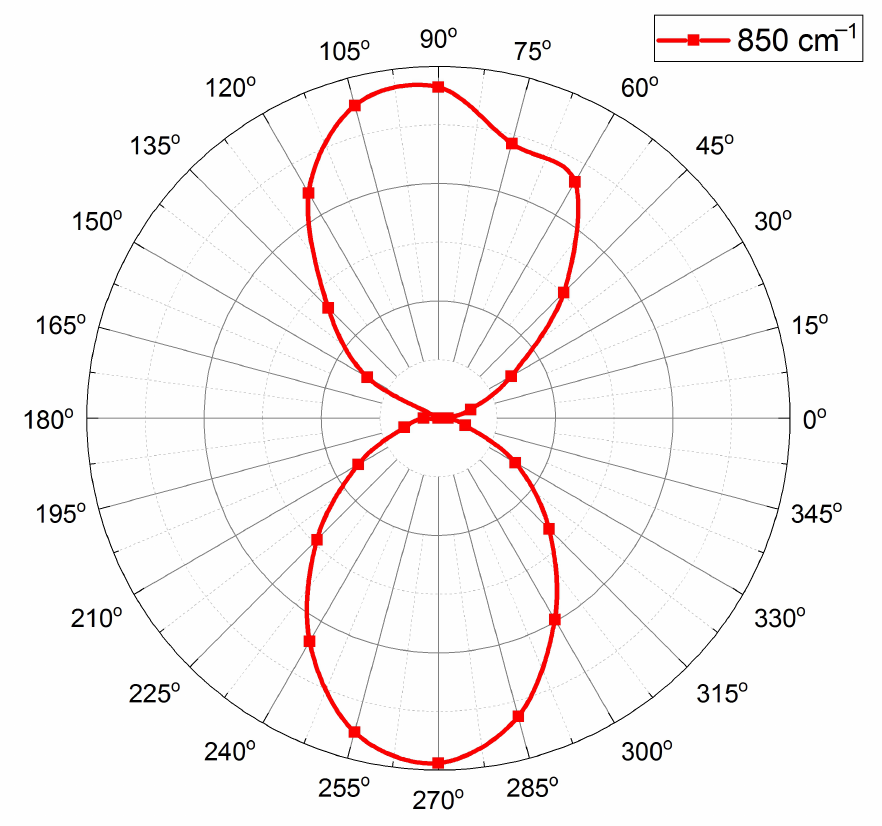
Figure 5. Effective polarization calculated for the given wavenumber 850cm − 1 , as follows: ( T ( φ ) / T ( 0 ◦ ) − min [ T ( φ ) / T ( 0 ◦ )]) / ( max [ T ( φ ) / T ( 0 ◦ )] − min [ T ( φ ) / T ( 0 ◦ )])